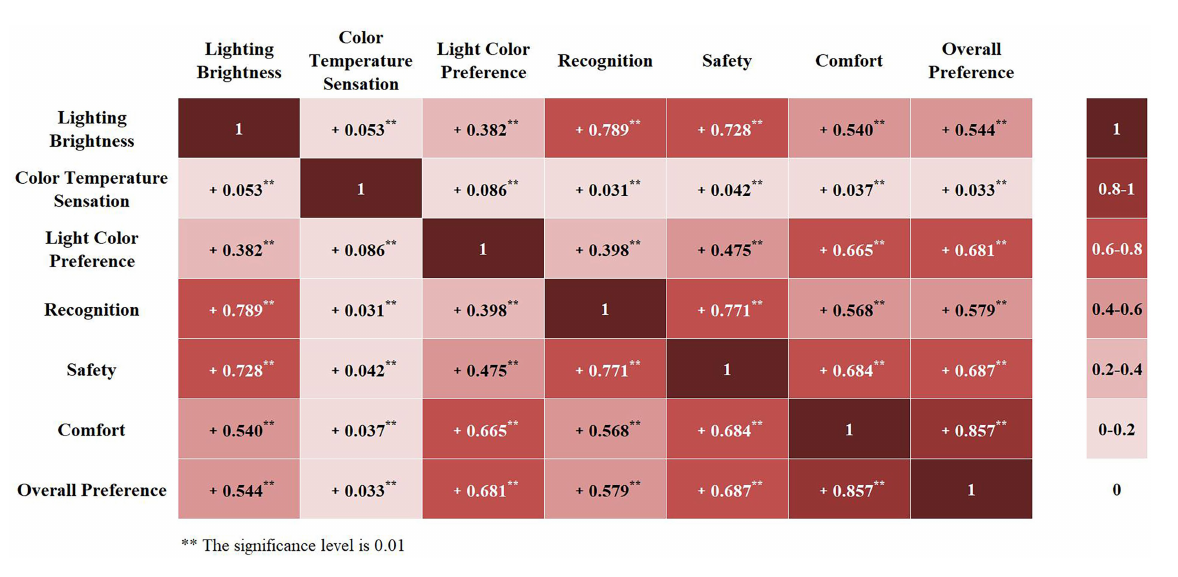
FIGURE 4 Heat map of the correlation coefficient matrix between dependent